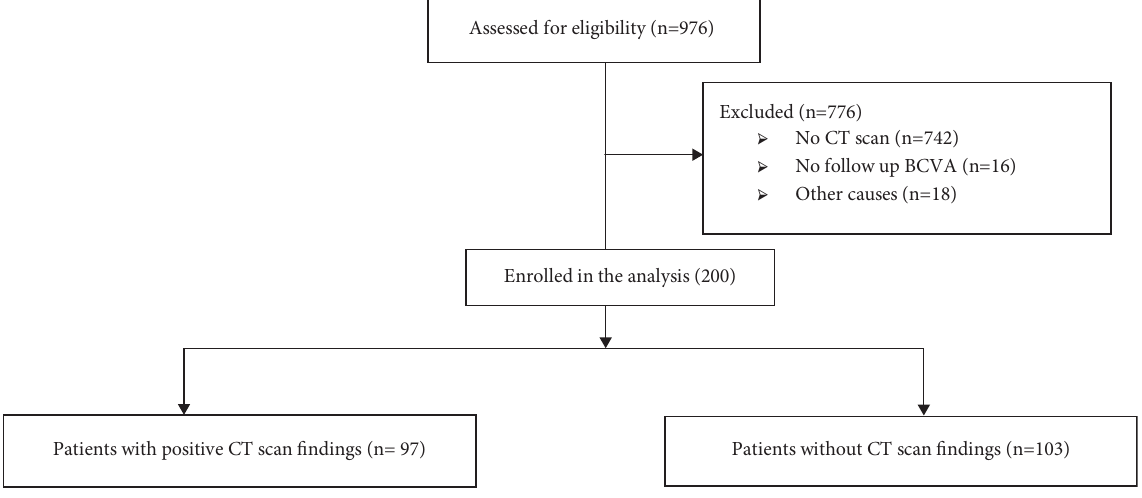
Figure 1: Flow diagram of the enrollment in the study. Table 1: Baseline demographic characteristics of patients with traumatic eye injury in patients with and without CT scan findings. Characteristics